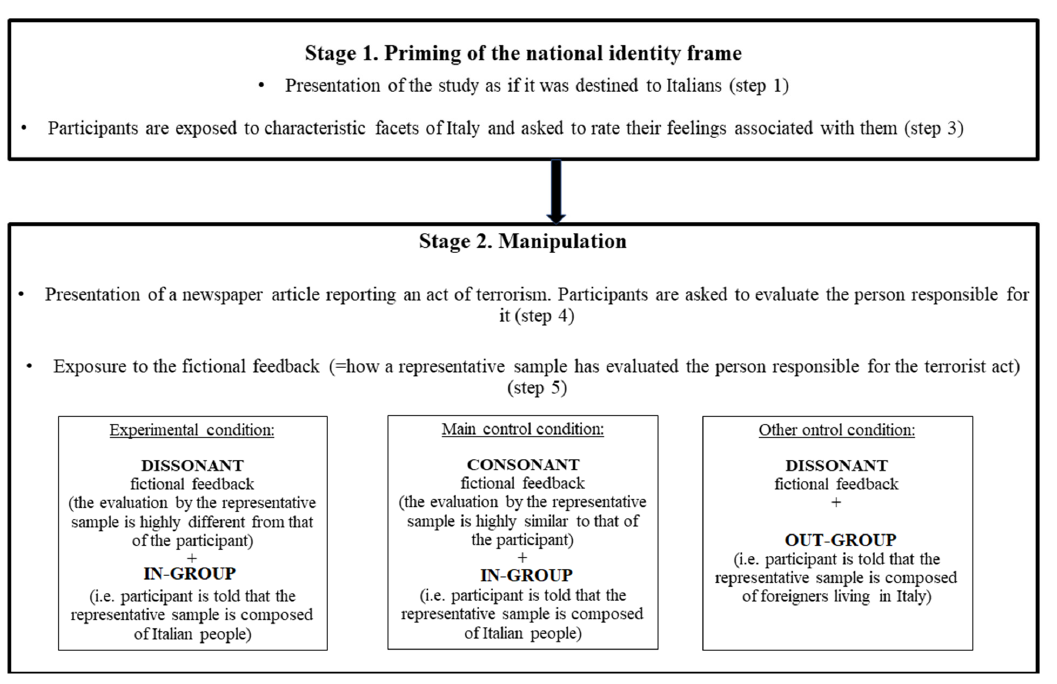
Figure 2. Architecture of the experimental